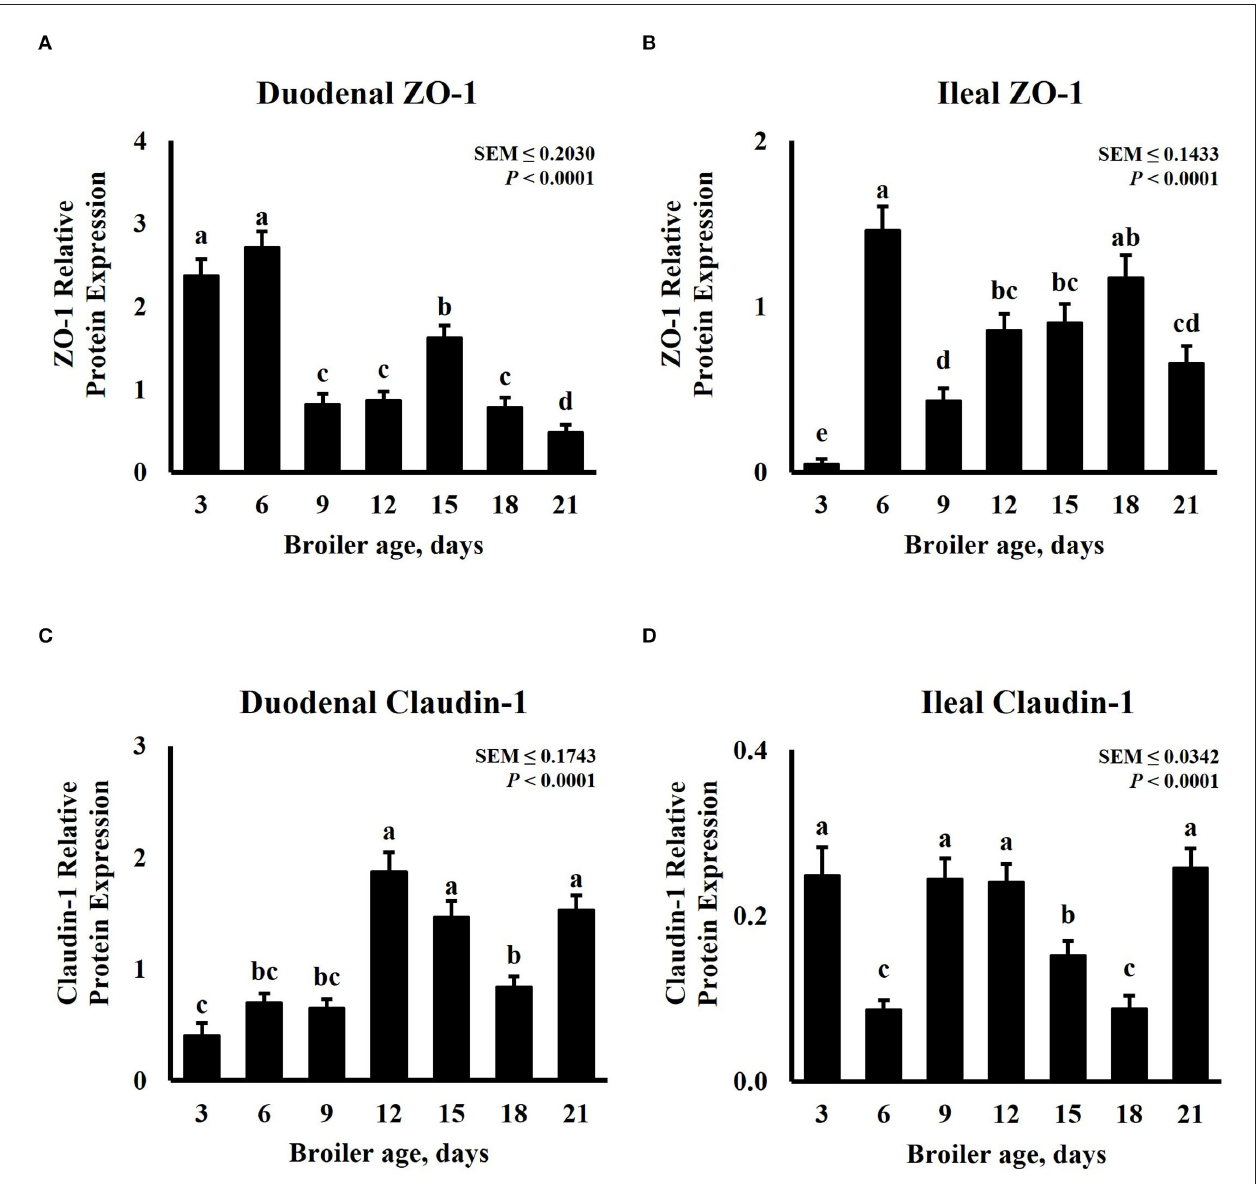
FIGURE 4 | Effect of bird age on intestinal tight junction protein abundance. On each sampling day, a total of 24 birds (n = 12 birds per treatment) were selected for tissue collection. Protein expression was measured using quantitative, fluorescent Western Blot relative to total protein. (A) Duodenal ZO-1 abundance, (B) Duodenal Claudin-1 abundance, (C) Ileal ZO-1 abundance, and (D) Ileal Claudin-1 abundance. a − e Bars with different superscripts differ at P ≤